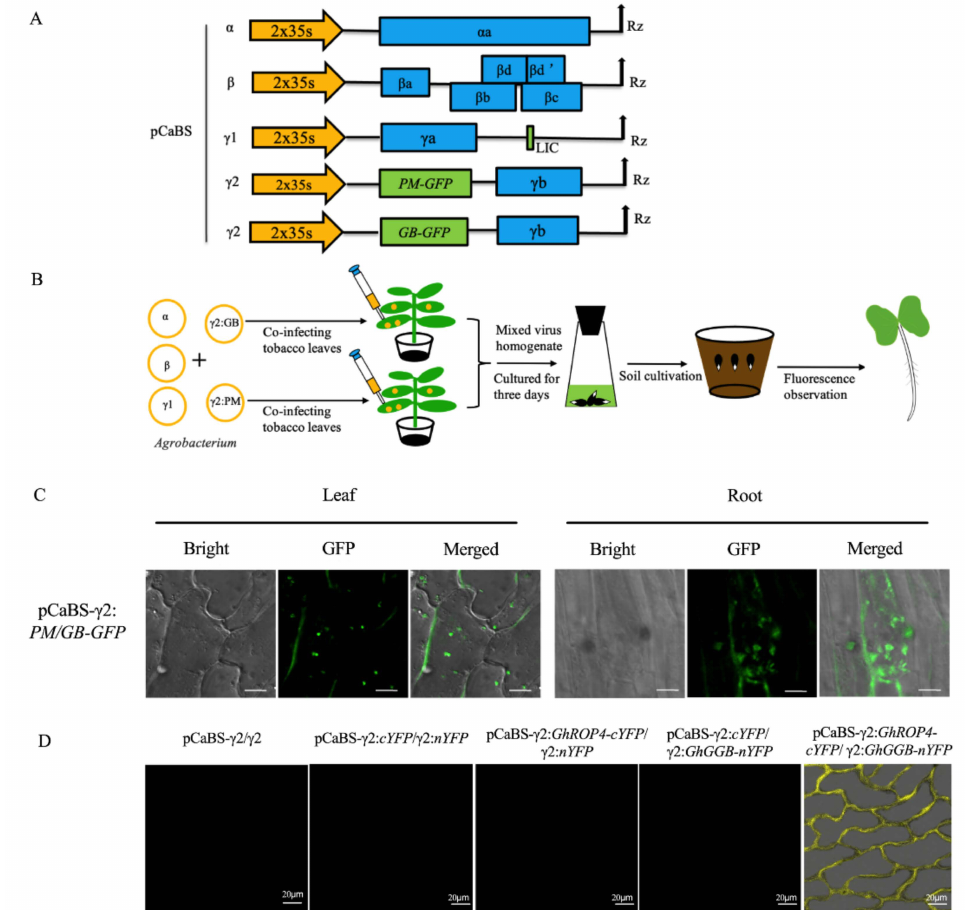
Figure 5. The co-location and protein–protein interactions in cotton mediated by the BSMV system. ( A ) Schematic representation of BSMV recombinant constructs applied to co-express two proteins. The open reading frames (ORFs) of PM-GFP and GB-GFP were in-frame inserted into the gene insertion cassettes of pCaBS- γ 2 vectors for simultaneous expression; ( B ) workflow of BSMV medicated co- localization in cotton; ( C ) co-expression of the PM marker and GB marker in one cell. The scale bar is 5 µ m; ( D ) in vivo visualization of GhROP4-GhGGB interactions in cotton cells. Each BSMV recombinant construct was mechanically inoculated into cotton as indicated at the top of each